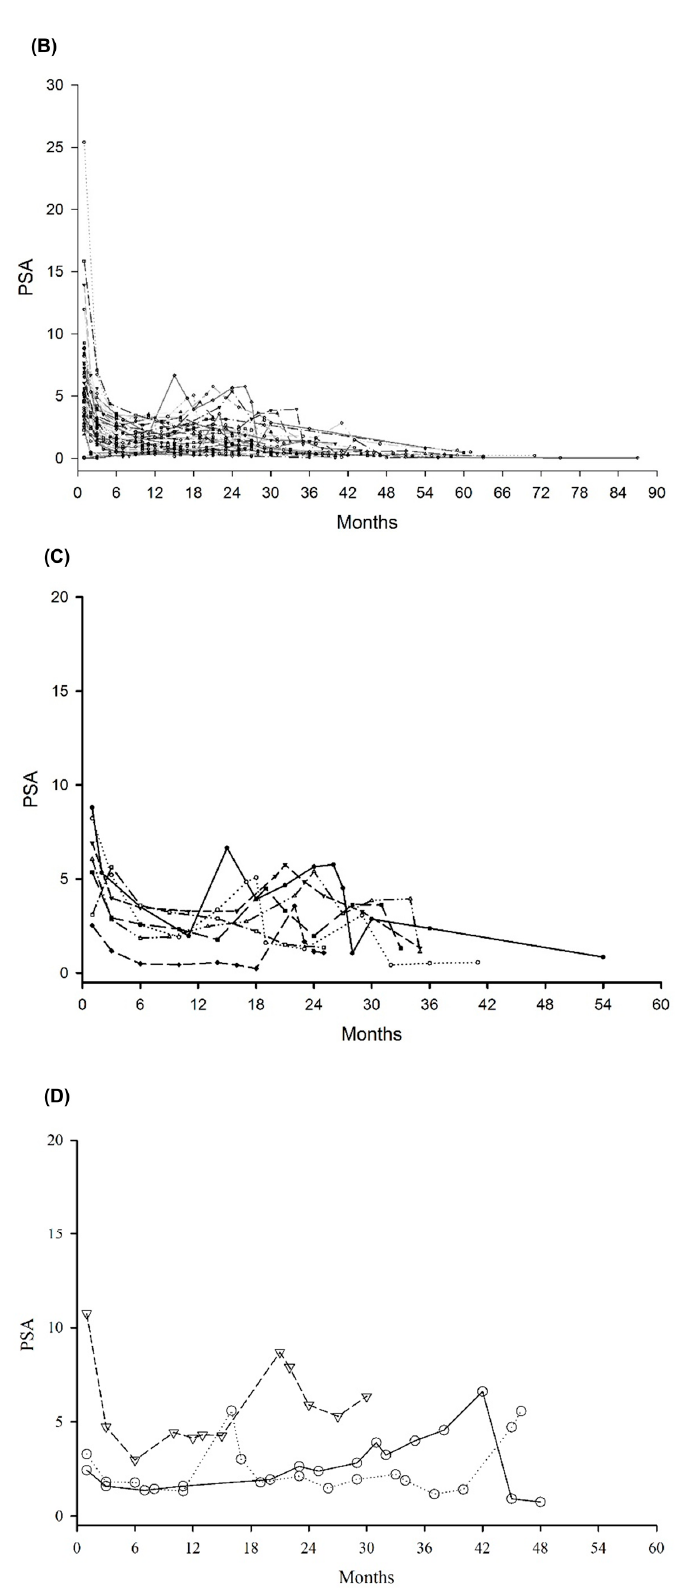
Figure 1. ( A ) PSA value for patients without bounce; ( B ) PSA value for patients with bounce; ( C ) PSA value for patients with large bounce; ( D ) PSA value for patients with failure. PSA, prostate- specific antigen.